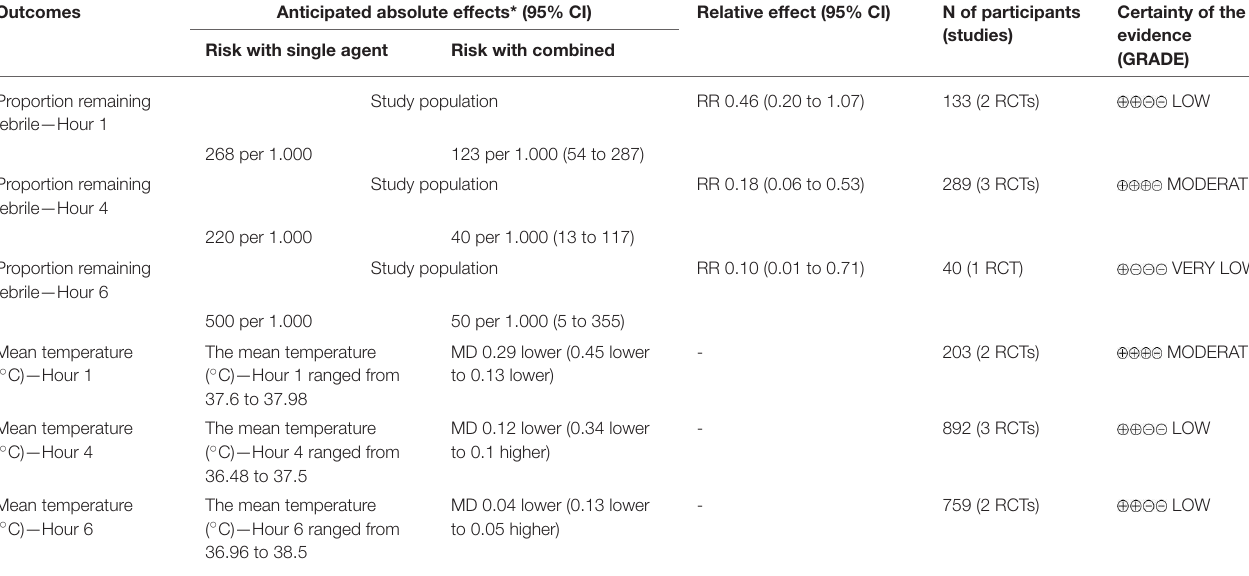
TABLE 6 | Summary of findings: combined therapy vs. single agent. Outcomes